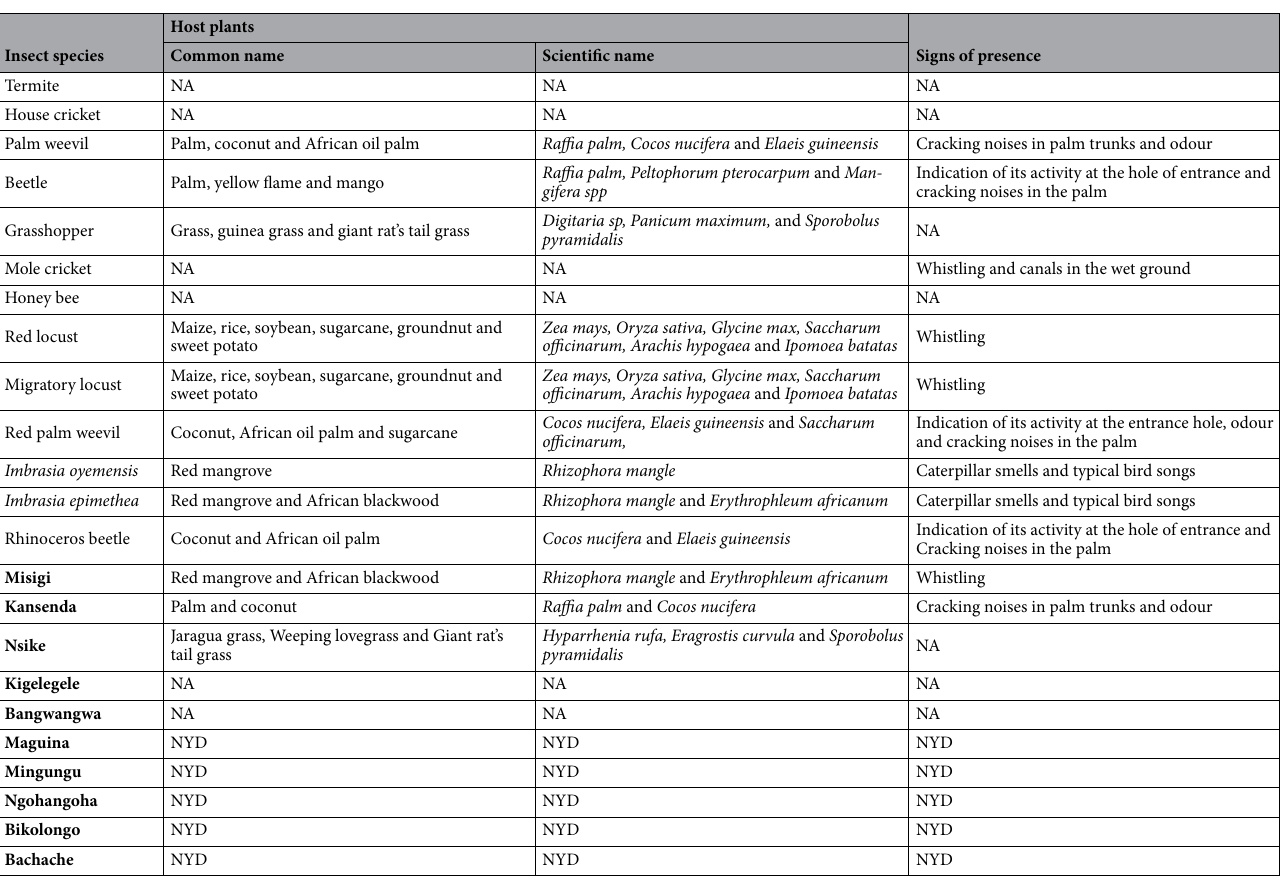
Table 4. Host plants of various consumed edible insects. NA Not applicable, NYD Not yet